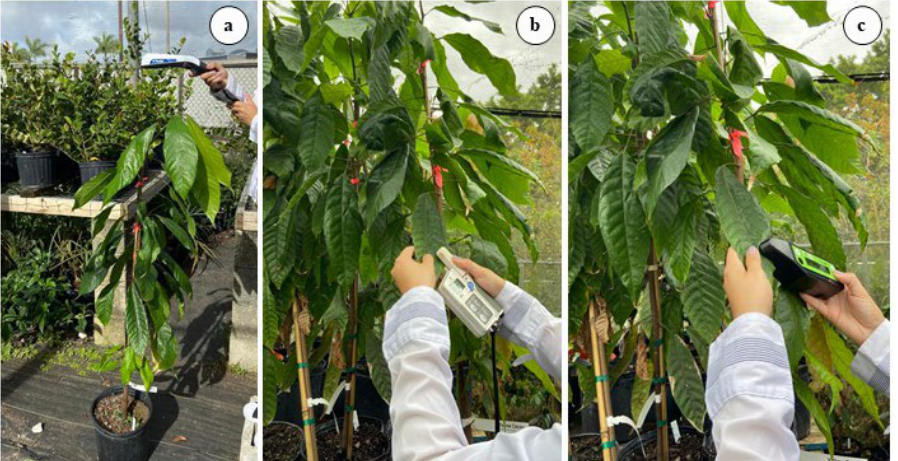
Figure 1. Optical sensors readings: ( a ) NDVI; ( b ) SPAD; and ( c ) atLEAF.